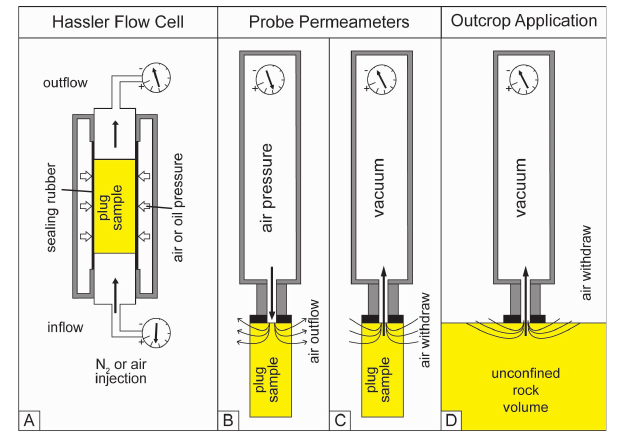
Fig. 1. Principles of permeability measurements on plug samples: (A) Hassler cell, (B) minipermeameter using air injection, and (C) minipermeameter applying a vacuum. Note the difference in rock volume and flow trajectories in (A) , (B) , (C) . Likewise, the differ- ence in rock volume needs to be taken into account when conduct- ing outcrop measurements=unconfined rock volume (D)